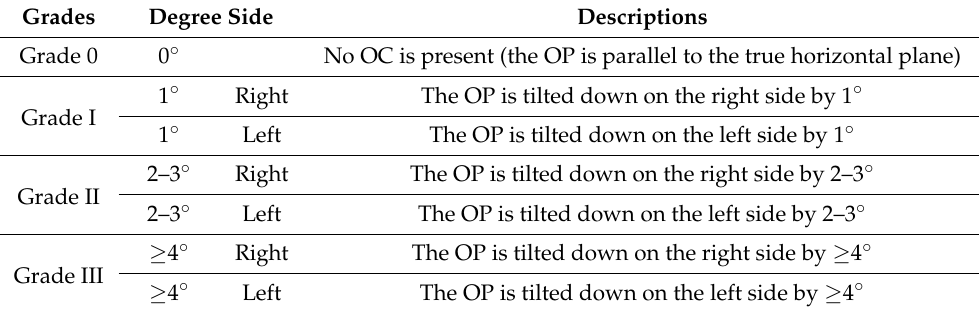
Table 1. Occlusal Cant Index (OCI)